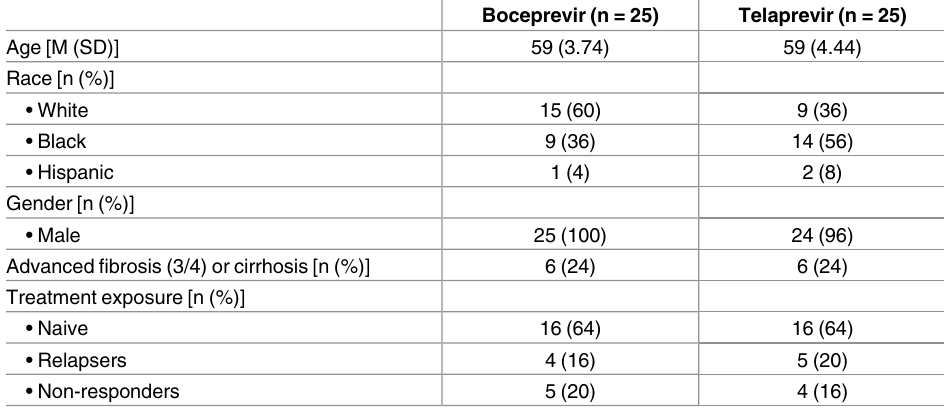
Table 1. Demographic characteristics of patients randomized to boceprevir and telaprevir.